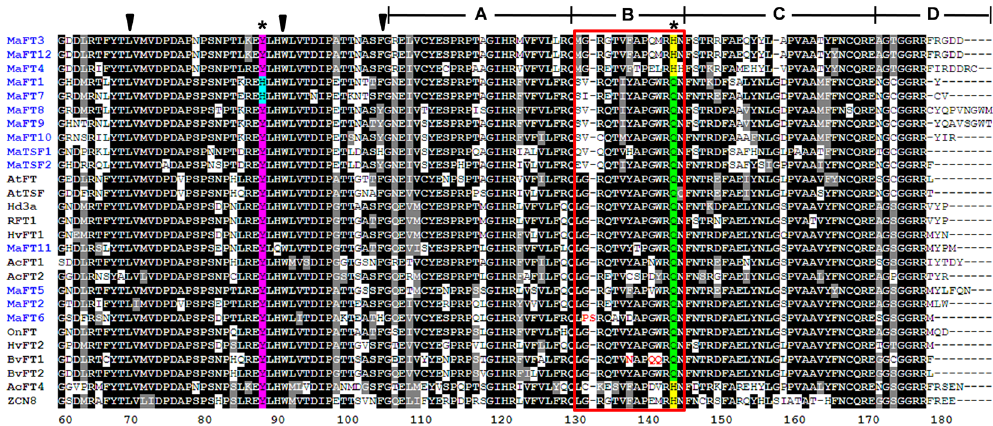
Figure 4. Alignments of partial deduced amino acid sequences of banana FT/TSF-like family proteins. The banana genes are highlighted in blue with functionally reported proteins in other plants, such as Arabidopsis, rice, barley, maize, orchid, sugarbeet and onion (accession numbers provided in materials and methods). Sequences were aligned using ClustalW and analyzed with BoxShade programme. Highly conserved amino acids are in black, grey or light depending on their level of identity (darker > grey > light). Triangles indicate the intron positions, which are conserved in plant PEBP family. Asterisks indicate the amino acid positions identified by Hanzawa et al . 41 as being related to antagonistic functions of FT and TFL1. The segment B within the box corresponds to an external P loop which is a potential ligand-binding pocket in the FT/TFL1